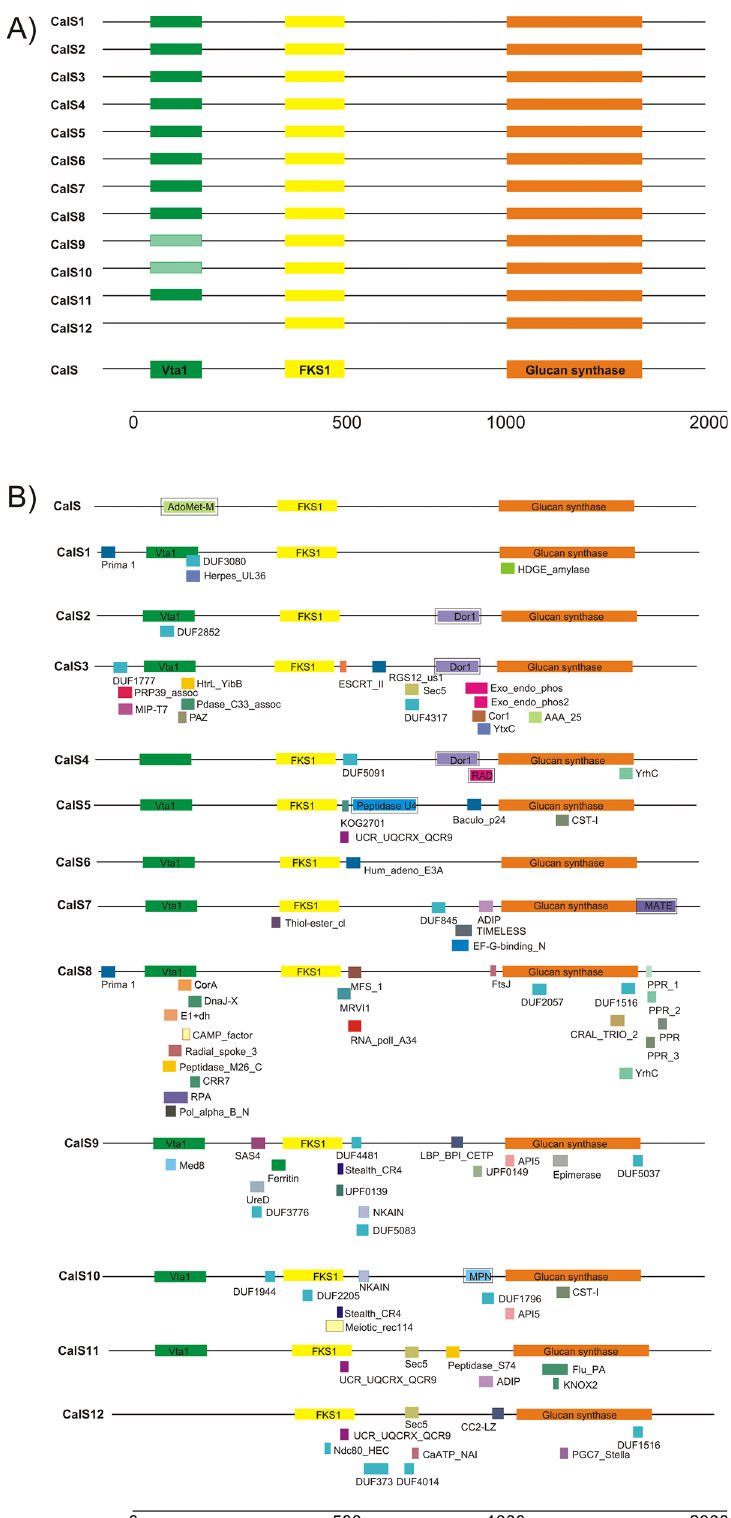
Fig 7. Consensus domains in the callose synthase proteins. A) Three main domainsfrom the Vta1 superfamily, 1,3-beta-glucan synthase subunit FKS1, and the 1,3-beta-glucan synthase superfamily.